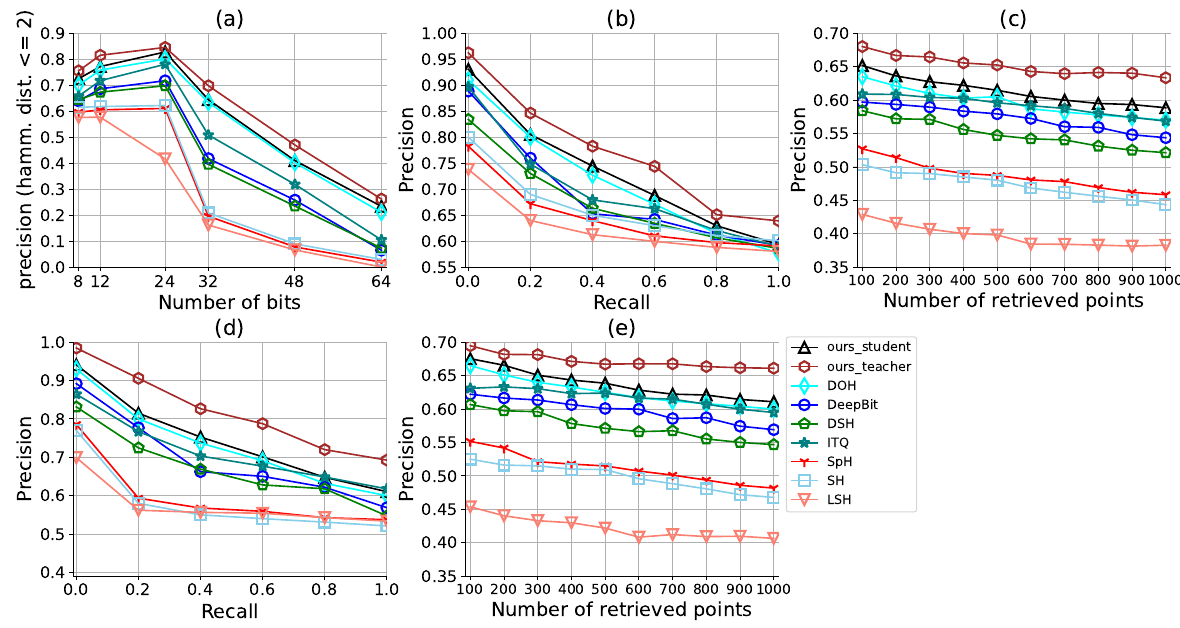
Figure 3. Performance curves of retrieval results on the MIRFlickr-25K dataset. ( a ) Precision using hash lookup within the Hamming radius 2; ( b ) Precision–recall curve for 48 bits; ( c ) Precision curve for 48 bits; ( d ) Precision–recall curve for 24 bits; and ( e ) Precision curve for 24